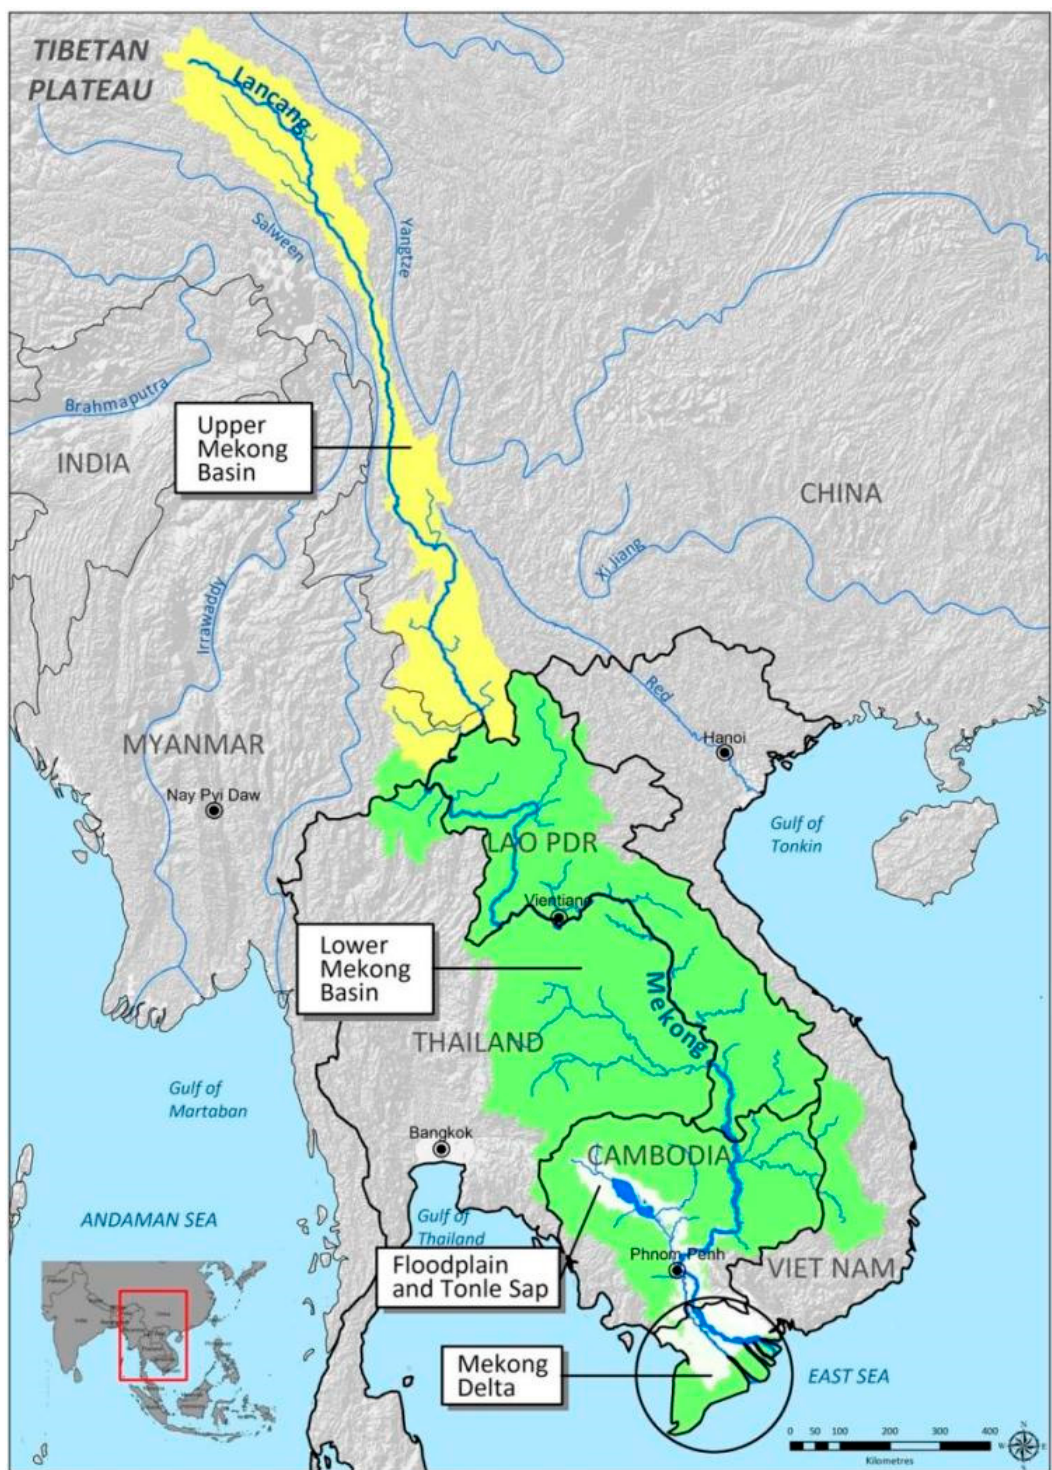
Figure 1. Mekong River basin [24].